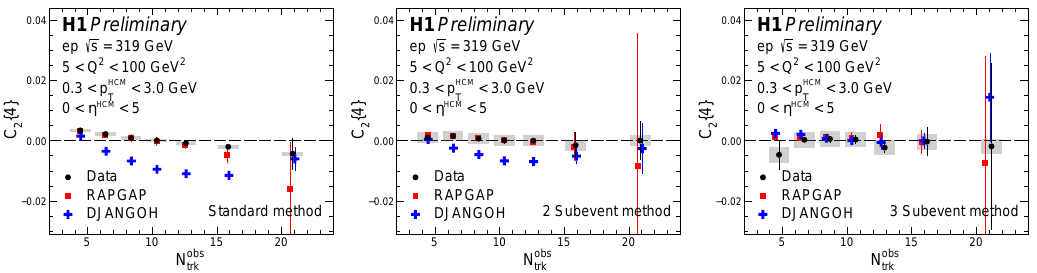
(cid:112) s = 319 GeV, within standard,